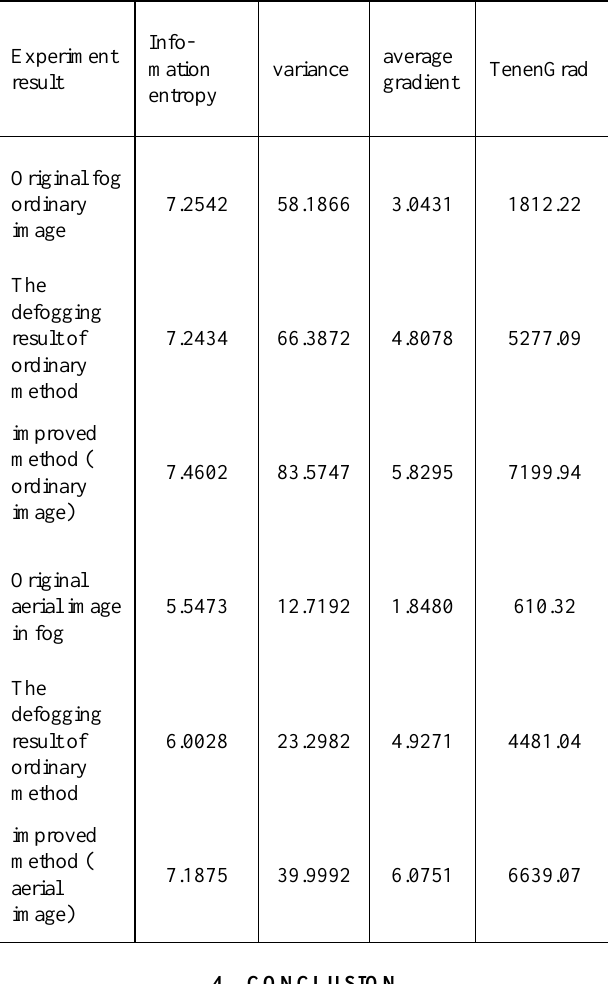
Table 1. Image quality evaluation